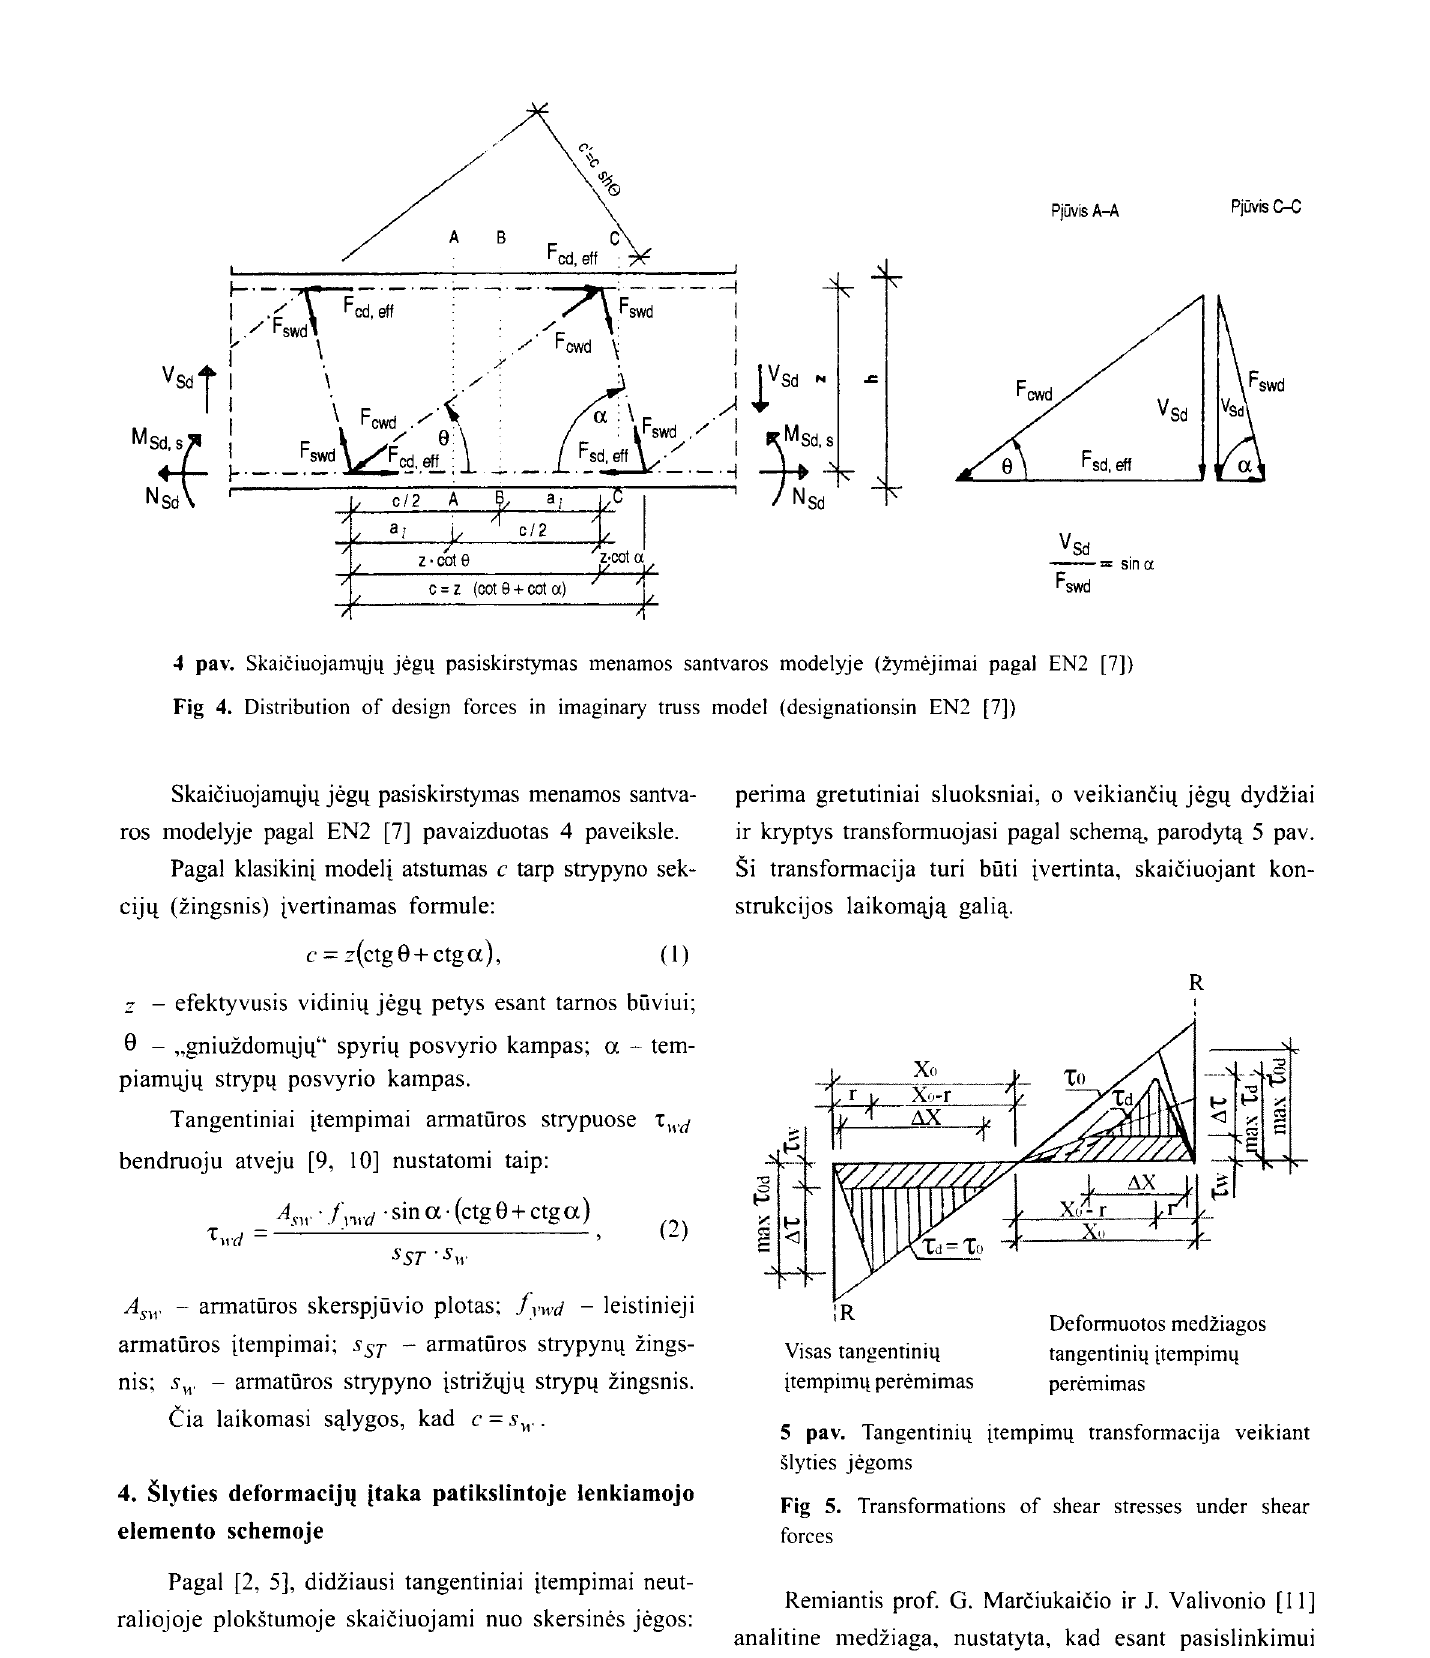
v5d - skersine jega; b - elemento plotis; z - vidinil!